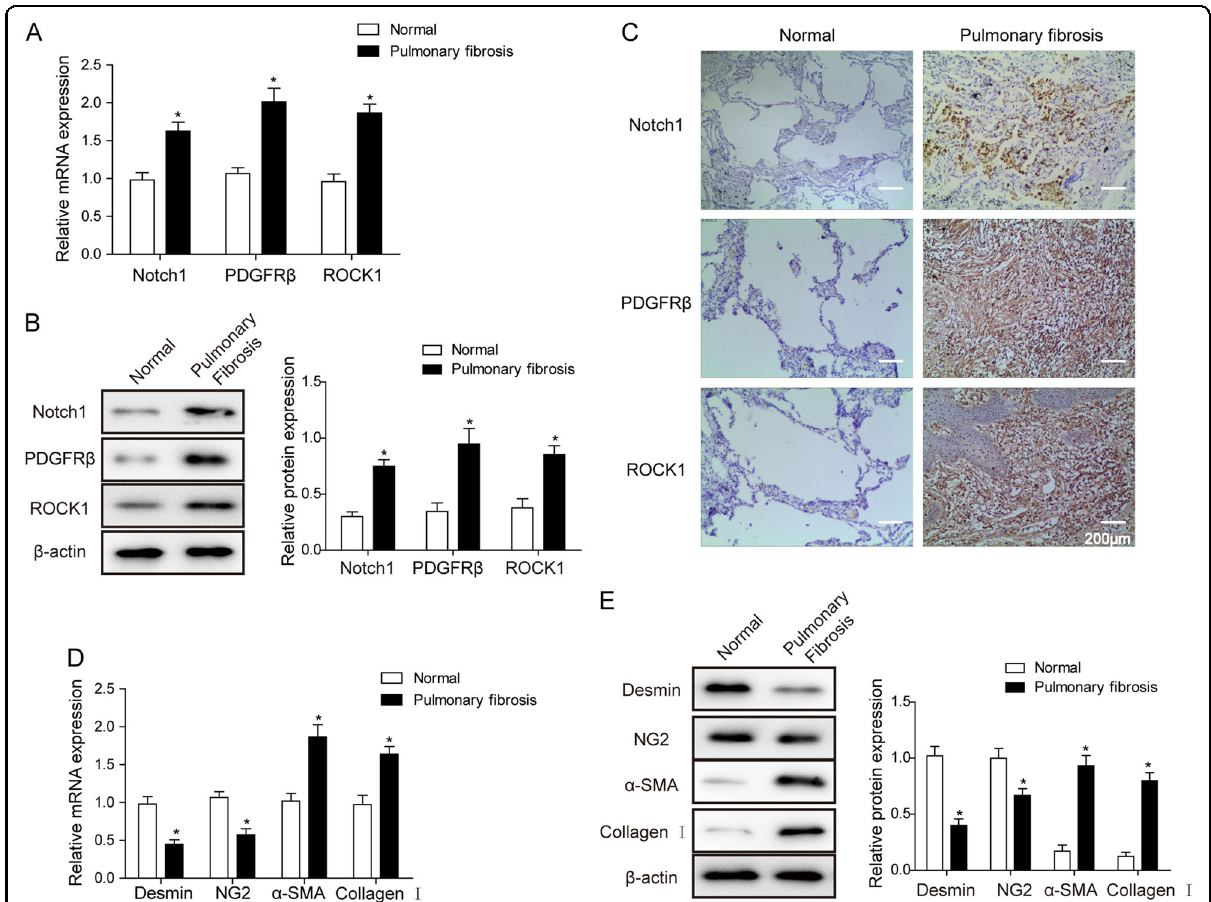
Fig. 1 Notch1 upregulation in pulmonary fi brosis tissues. a Relative mRNA expression level of the Notch1 signaling pathway in normal and fi brotic tissues. b Western blot for Notch1, PDGFR β , and ROCK1 proteins in normal and fi brotic tissues. β -actin was used as an internal control. c IHC staining for Notch1, PDGFR, and ROCK1 in lung tissues. d Relative mRNA level for the desmin, NG2, α -SMA, and collagen I genes in tissues. e Western blot for cell surface marker proteins. The means ± SD in the graph present the relative levels from three replicates. * p <